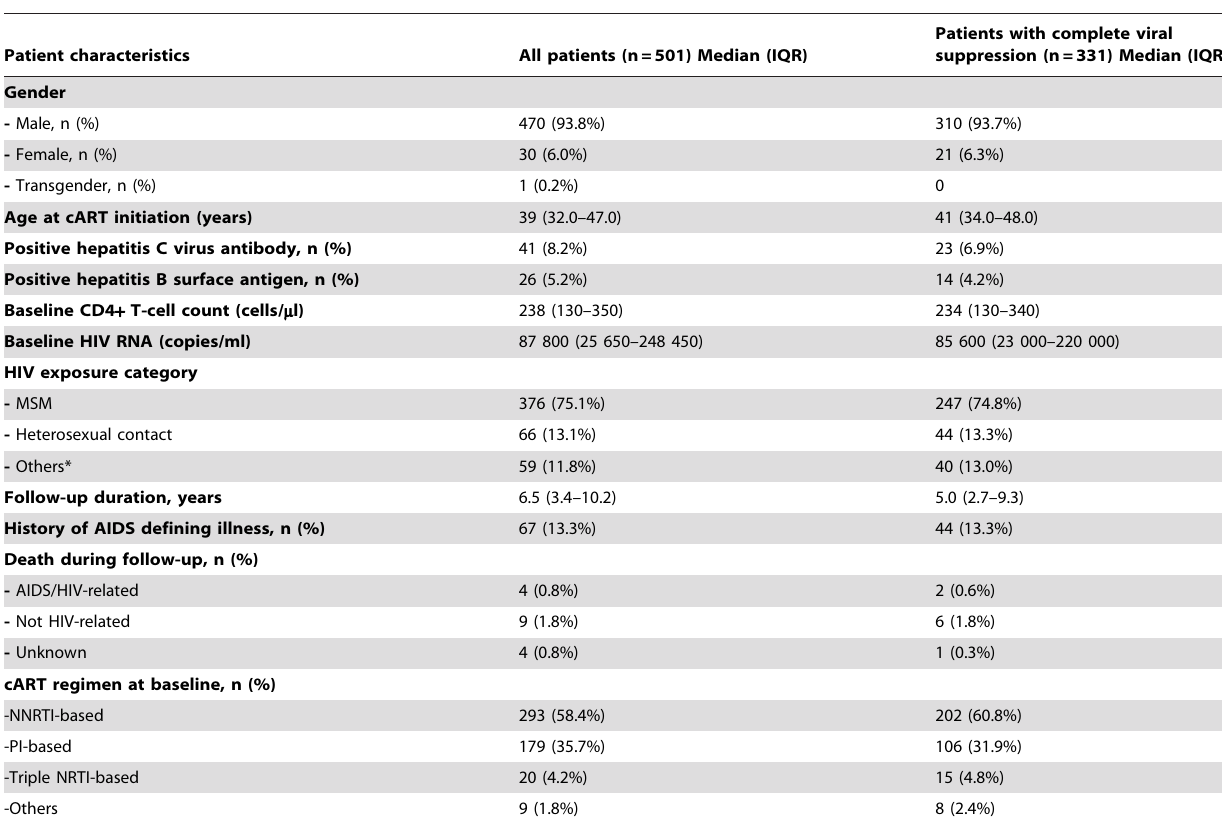
Table 1. Demographic and clinical characteristics of patients from AHOD who met the inclusion criteria for this study.